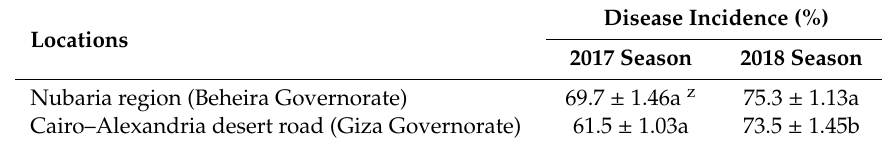
Table 1. Disease incidence (%) of dropped apple fruit in the investigated locations.